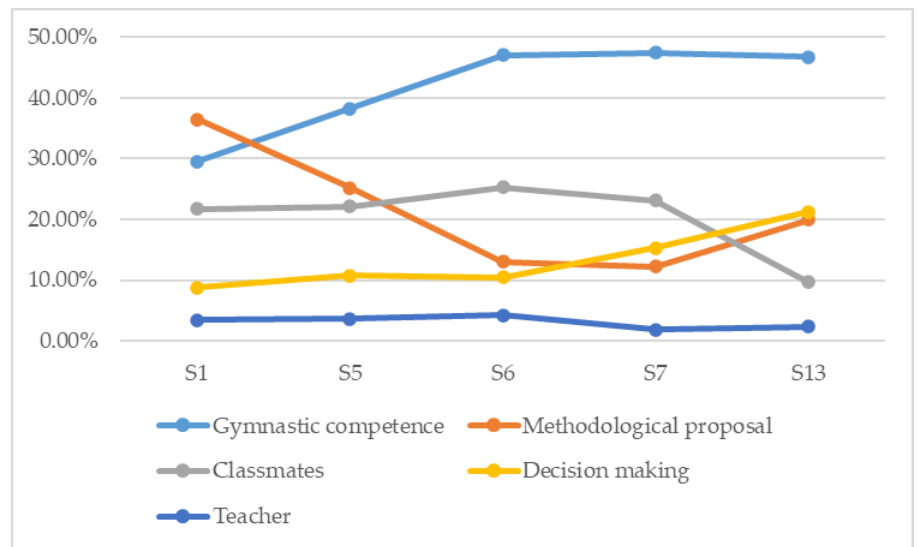
Figure 2. Satisfaction in gymnastics learning related to the perceptions about the learned gymnastic competence, the methodology proposal, the decision making, the classmates, and the teacher.